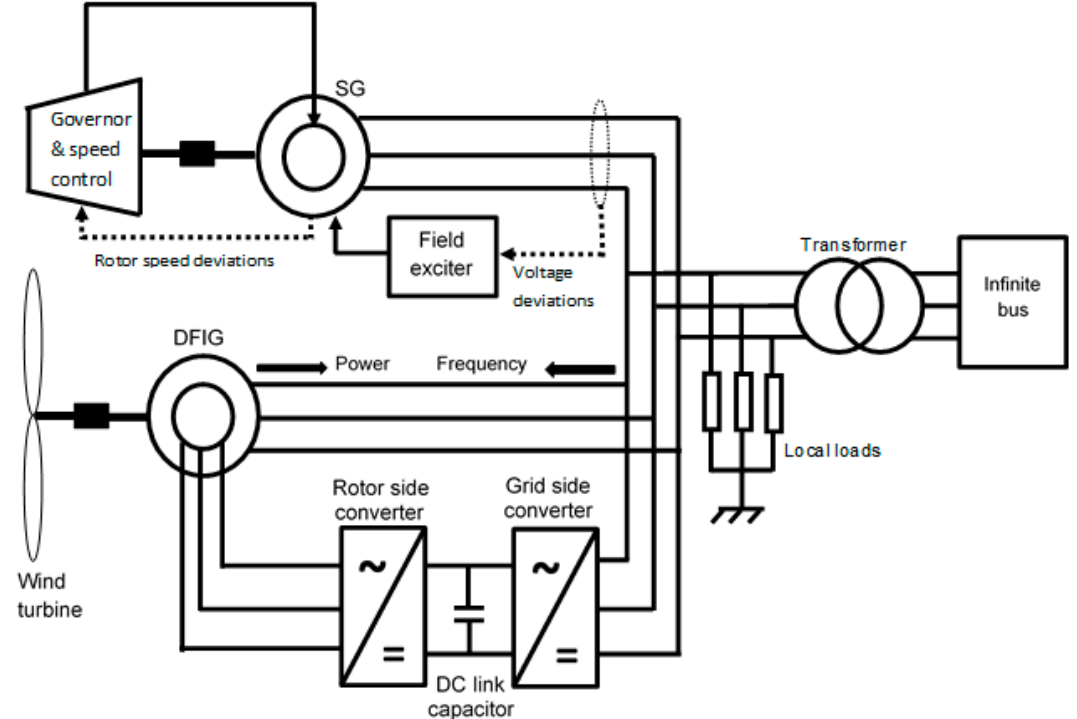
Figure 1. Structure diagram of the hybrid distributed energy resource.